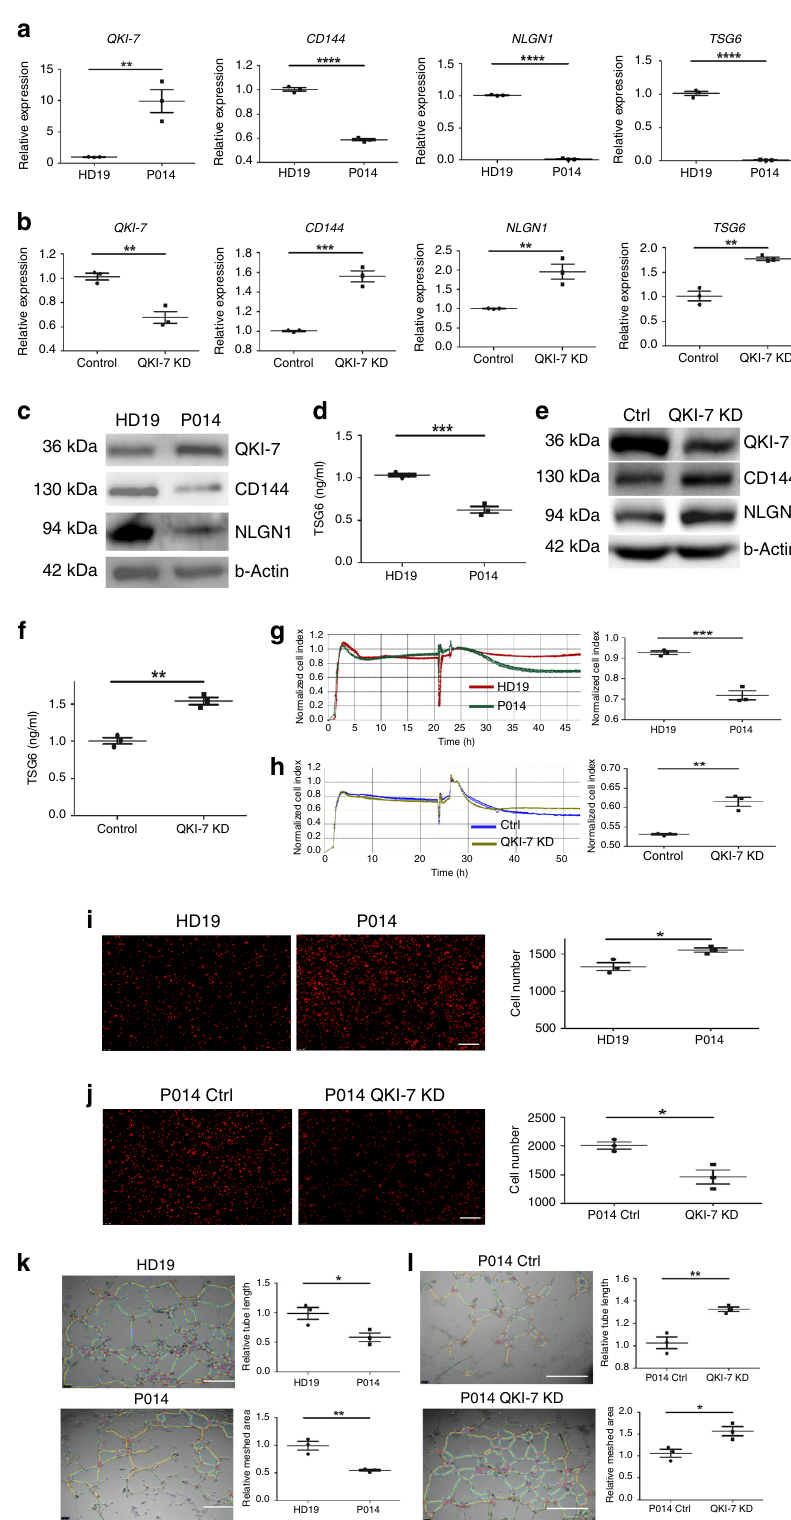
line the important role of QKI-7 in the regulation of critical EC related genes, which impair EC function under diabetic